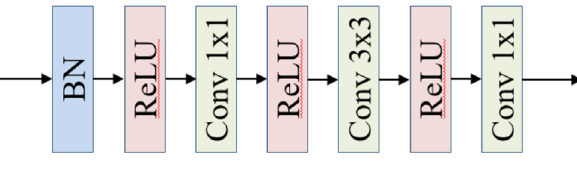
Figure 3. The structure of enhanced dense